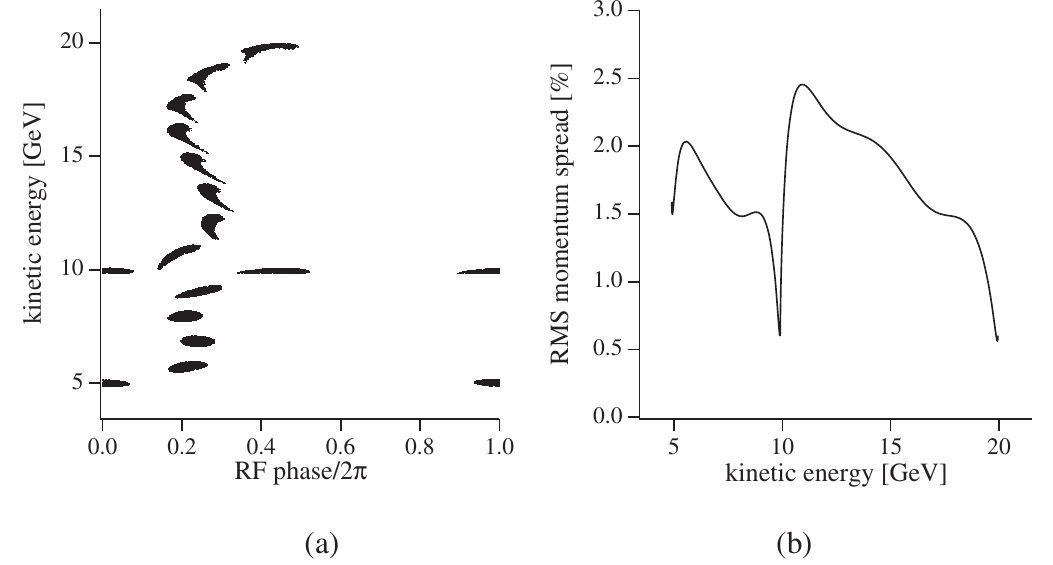
FIG. 7. (a) Longitudinal emittance evolution and (b) momentum evolution of a two FFAG cascade. Transverse emittance is